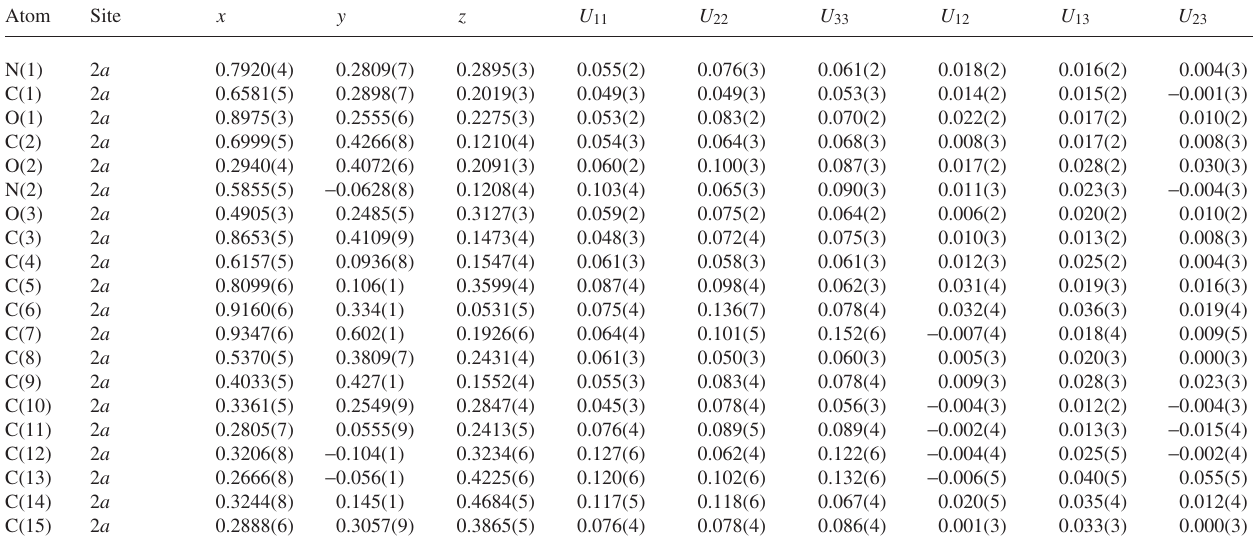
Table 3. Atomic coordinates and displacement parameters (in Å 2 )